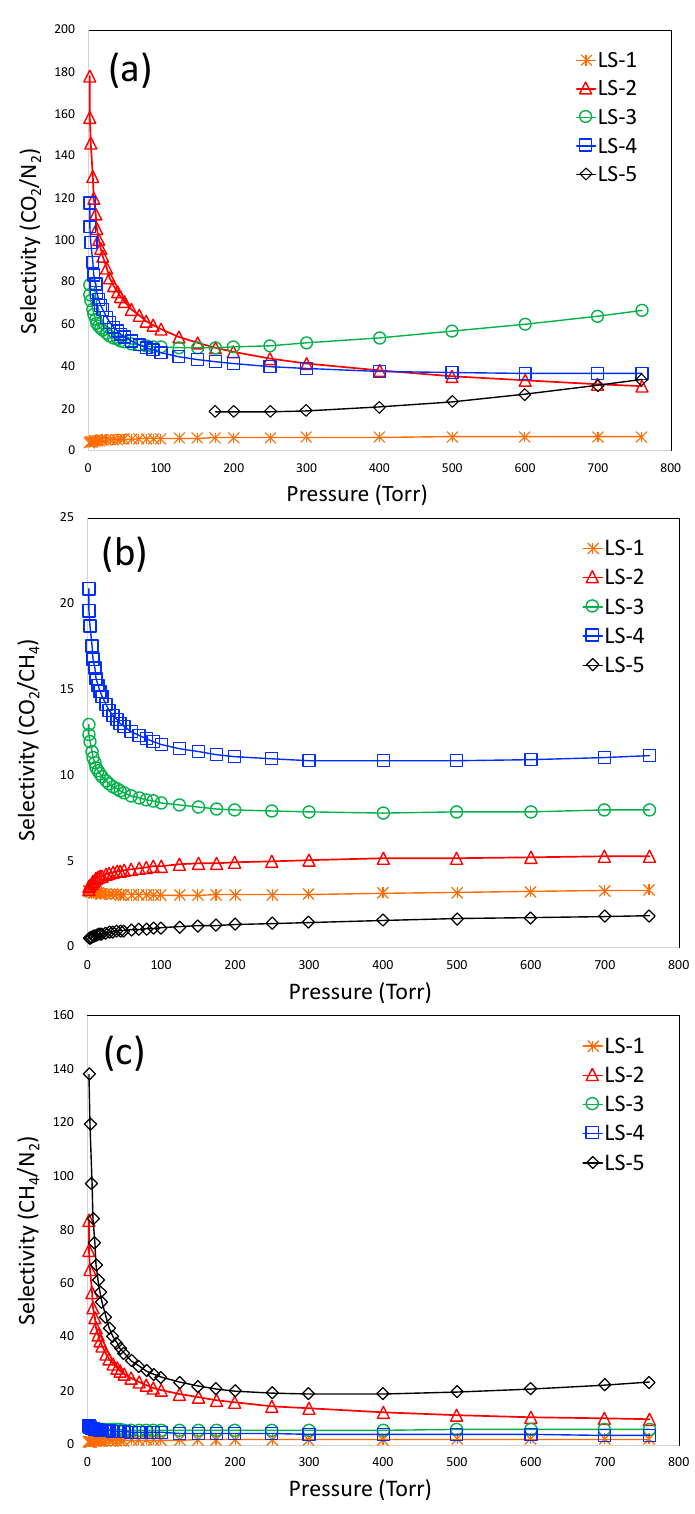
Figure 8. IAST-based selectivity for CO 2 /N 2 ( a ), CO 2 /CH 4 ( b ), and ( c ) CH 4 /N 2